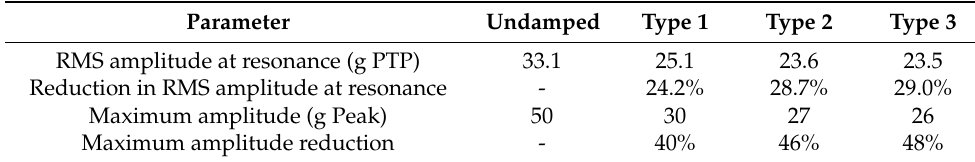
Table 2. Dynamic parameters at resonant rotational speed.